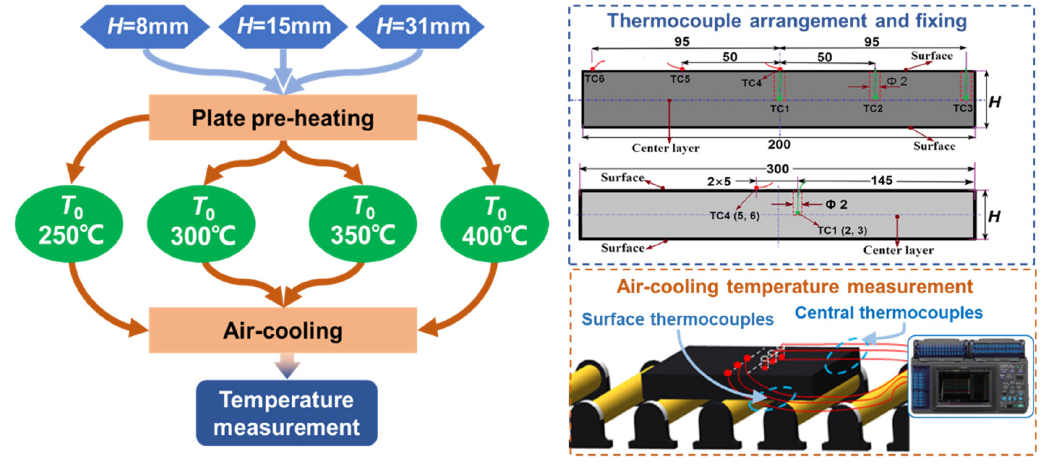
Figure 1. Real-time temperature measurement in air-cooling process.